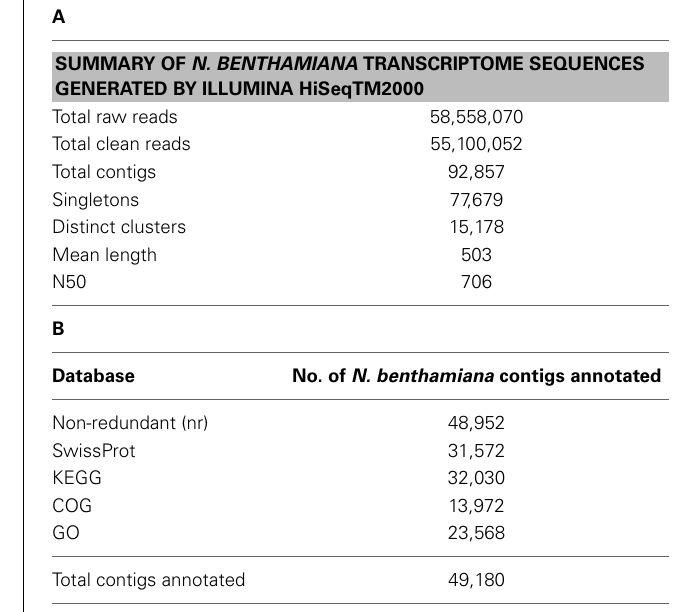
Table 1 | Summary of de novo assembling and annotation of